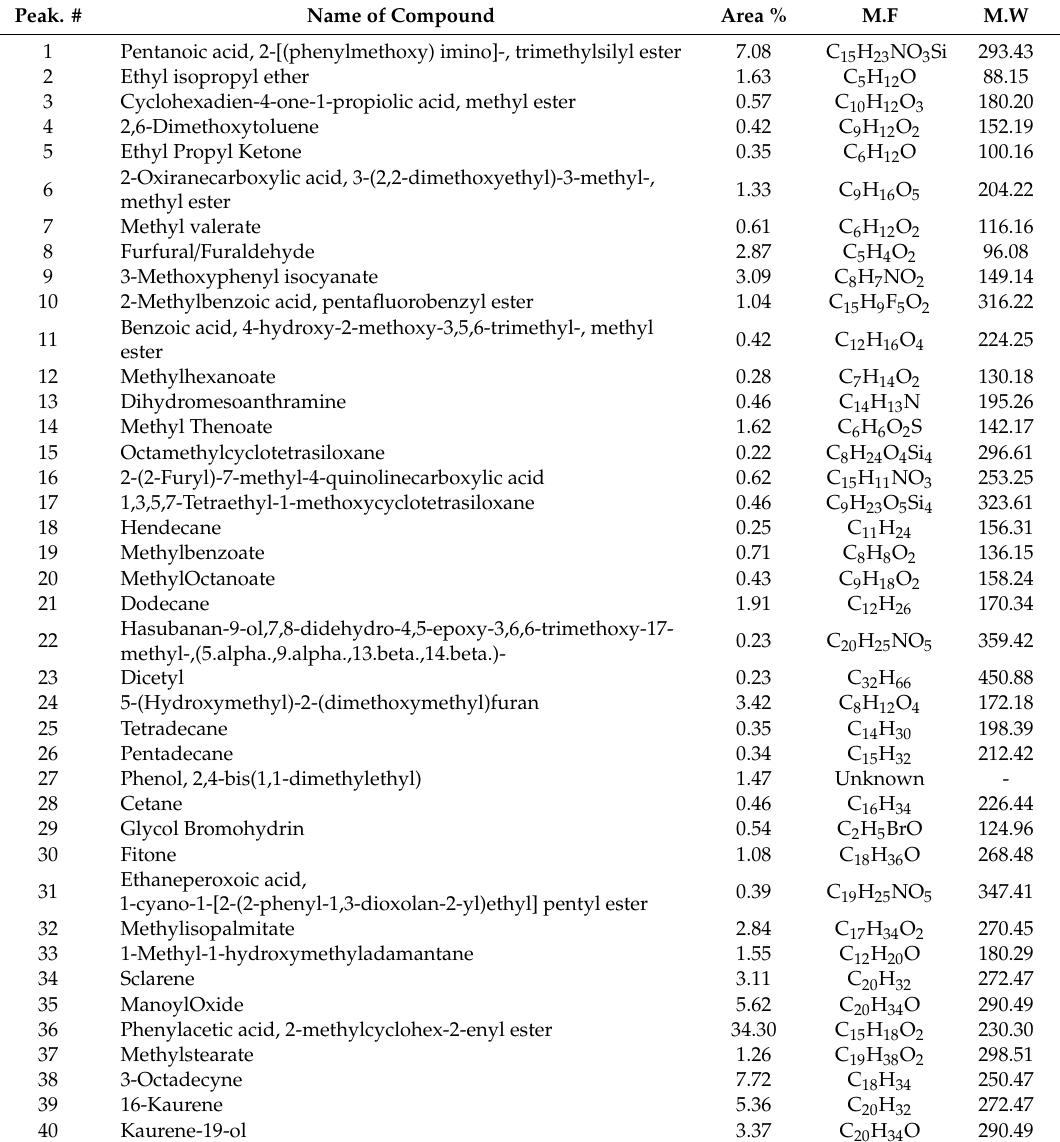
Table 3. Chemical composition of methanol extract of S. trifolia